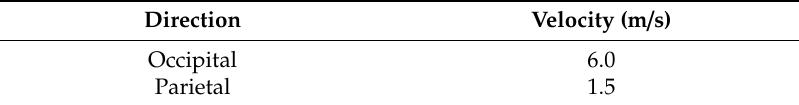
Table 5. Impact Scenarios.